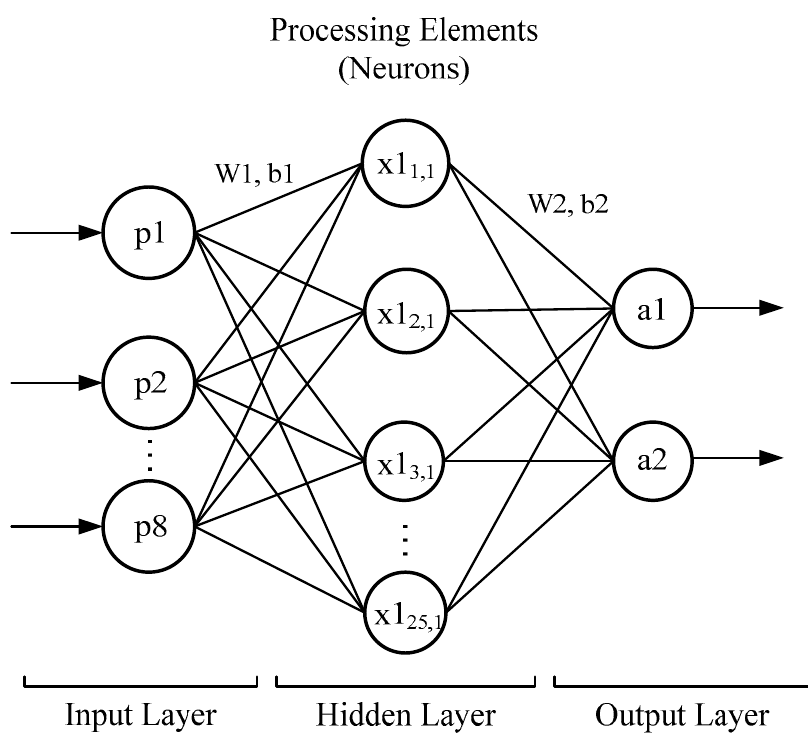
Figure 3. Diagram of three-layer neural network.